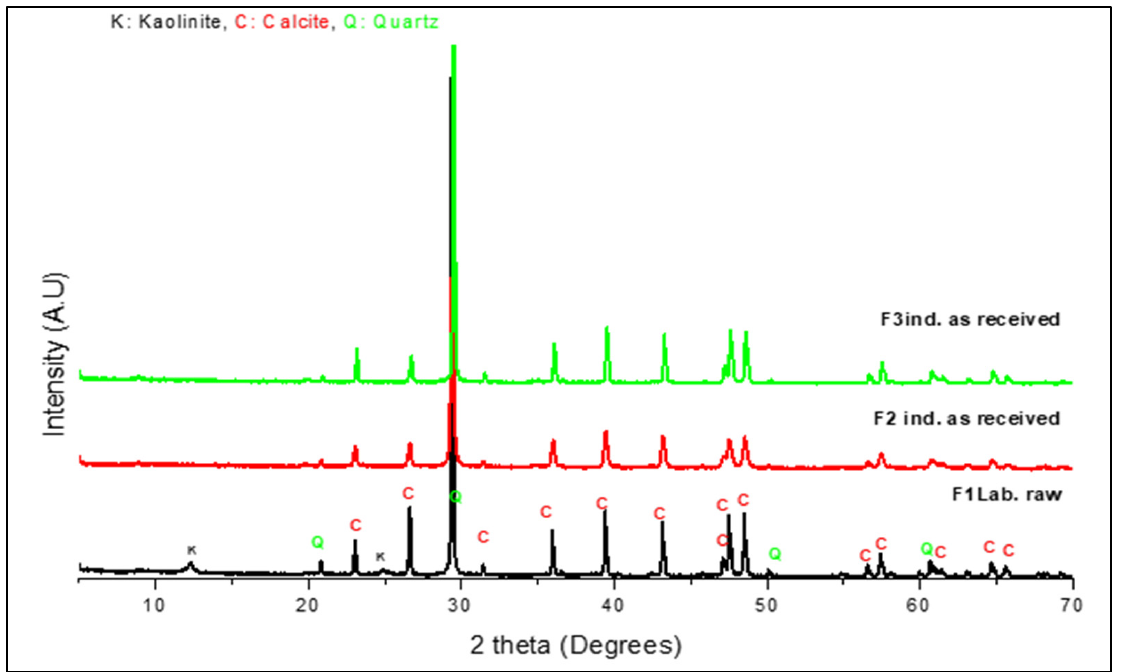
Figure 3. Diffraction patterns of the 3 premixes used.